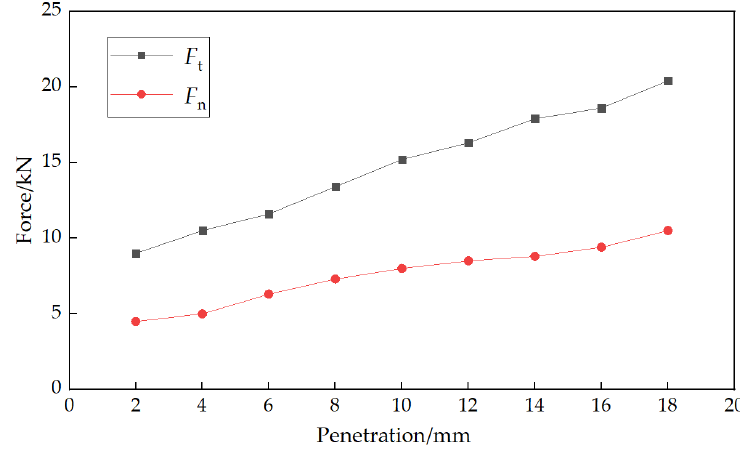
Figure 7. Cutting force and penetration force under different penetrations.